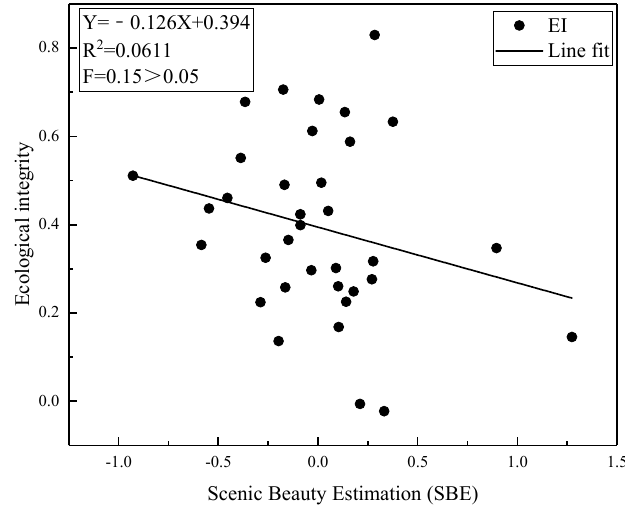
Figure 6. Linear fit of SBE and ecological integrity.